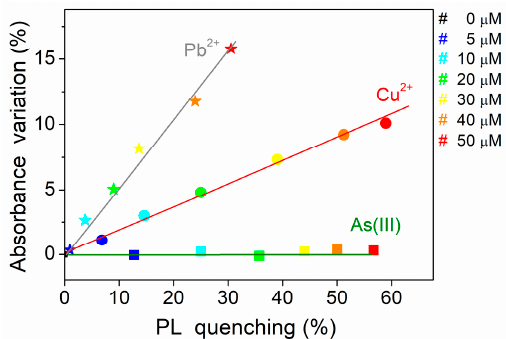
Figure 8. The relative increase of the apparent absorption, measured at λ a = 275 nm, plotted as a function of the relative quenching ratio (F 0 − F)/F 0 for each ion at different the concentrations according to the color scale on the right. The lines are guides for the eye.